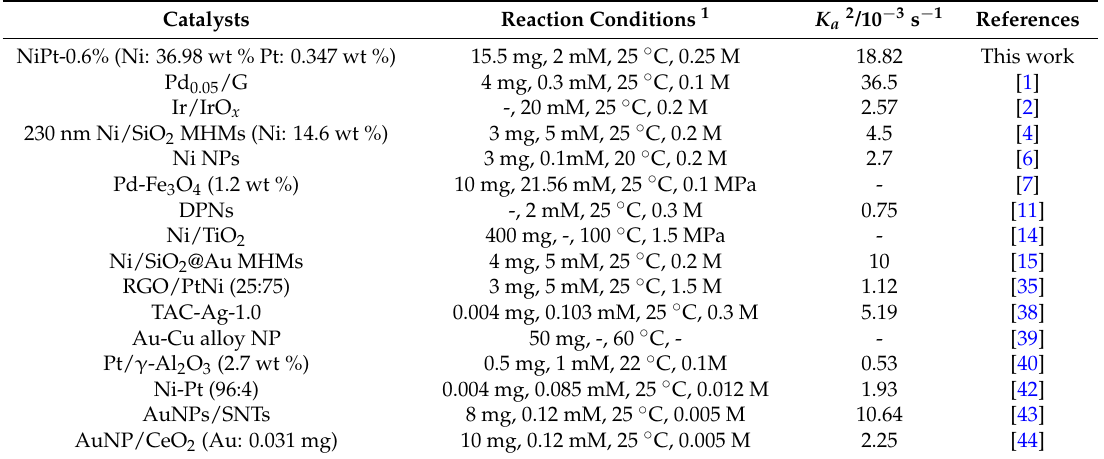
Table 3. Comparisons of the apparent rate constant ( K a ) for 4-NP reduction over various